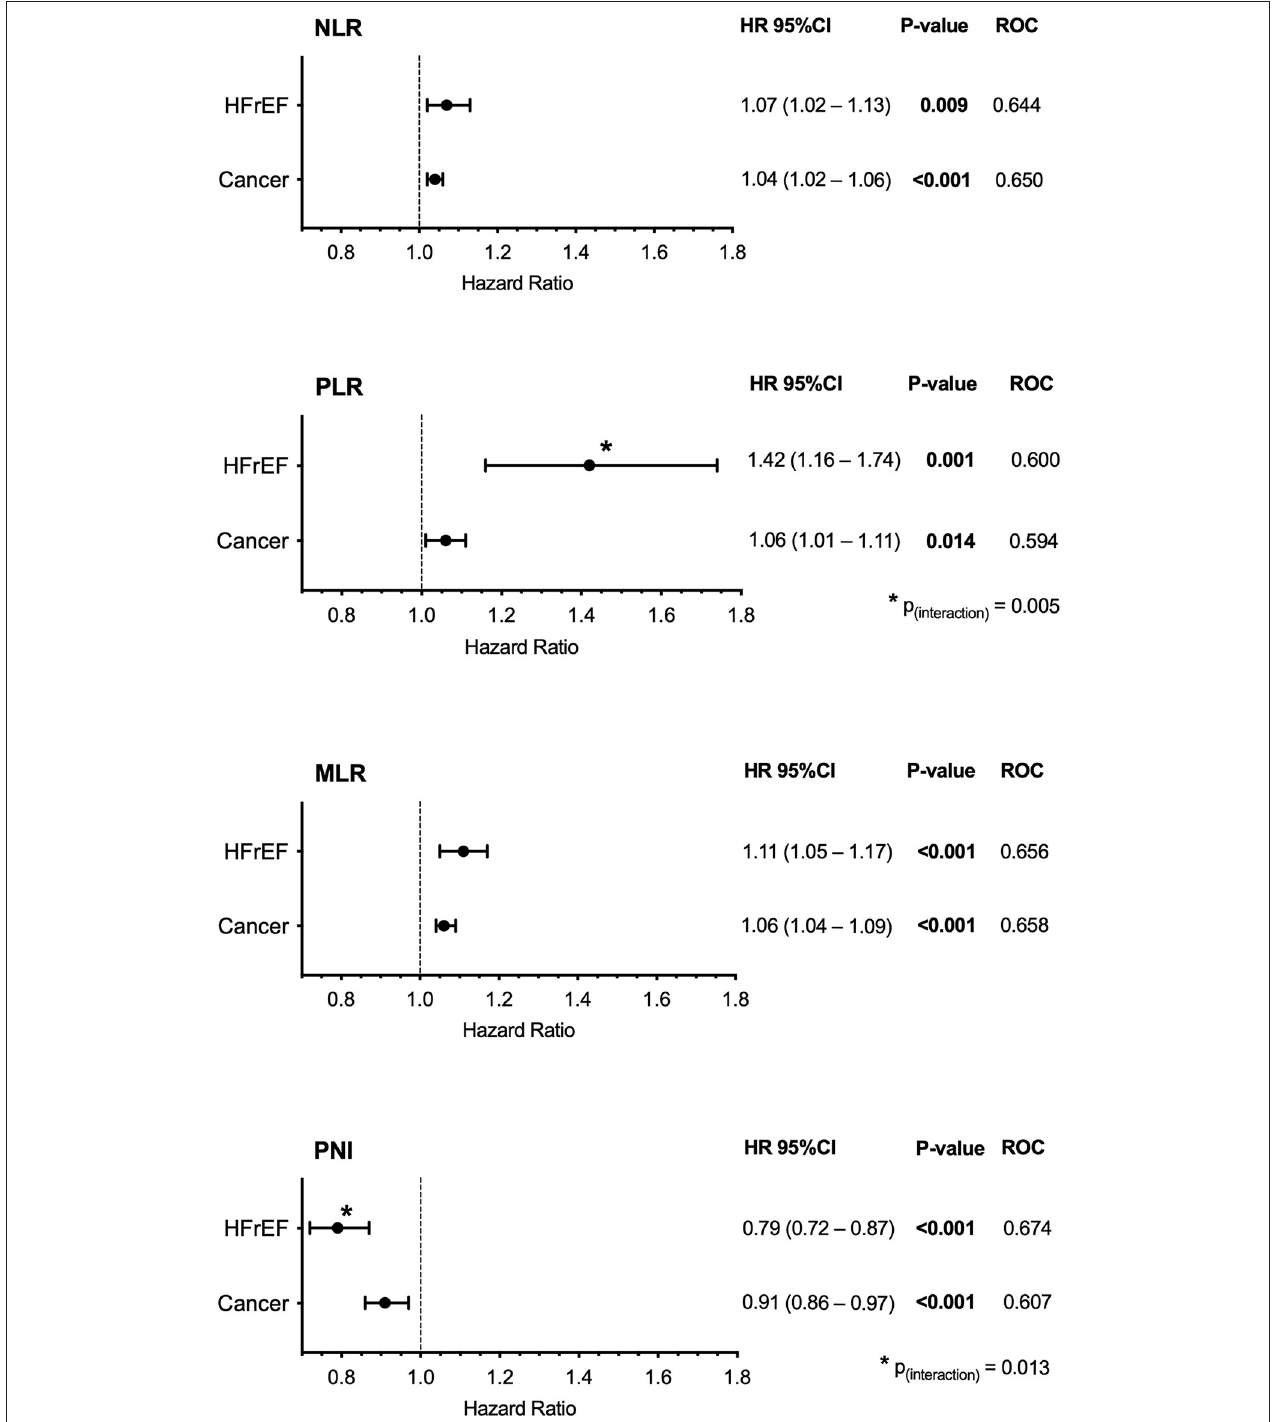
FIGURE 2 | Association of inflammatory scores with outcome in stable HFrEF ( n = 443) or treatment naïve cancer (solid and hematologic cancer) ( n = 375). Cox regression and ROC analysis of different inflammation-based prognostic scores are shown. NLR, Neutrophil-to-lymphocyte ratio; MLR, Monocyte-to-lymphocyte ratio; PLR, Platelet-to-lymphocyte ratio; PNI, Prognostic nutritional index.